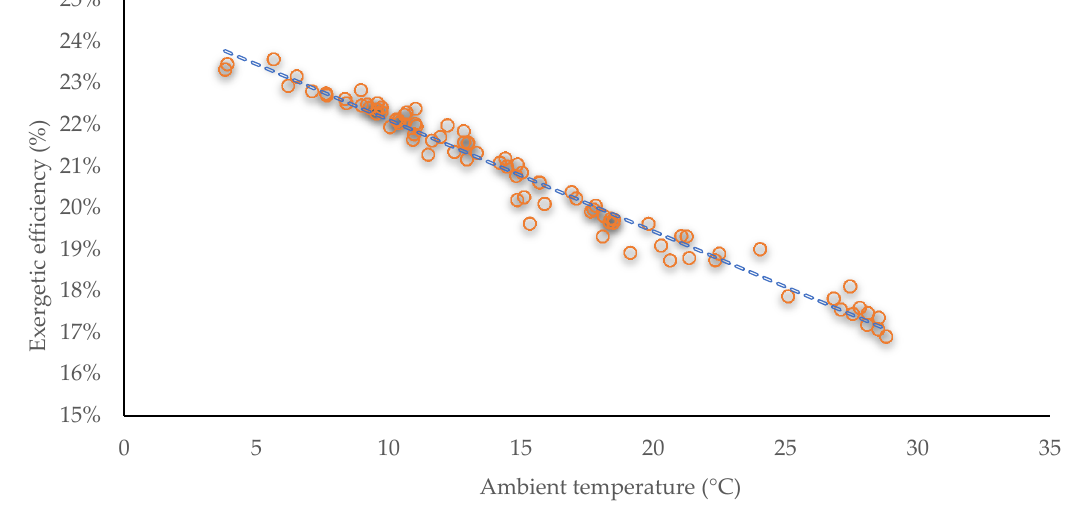
Figure 17. Correlation of exergy efficiency with the annual average ambient temperature.